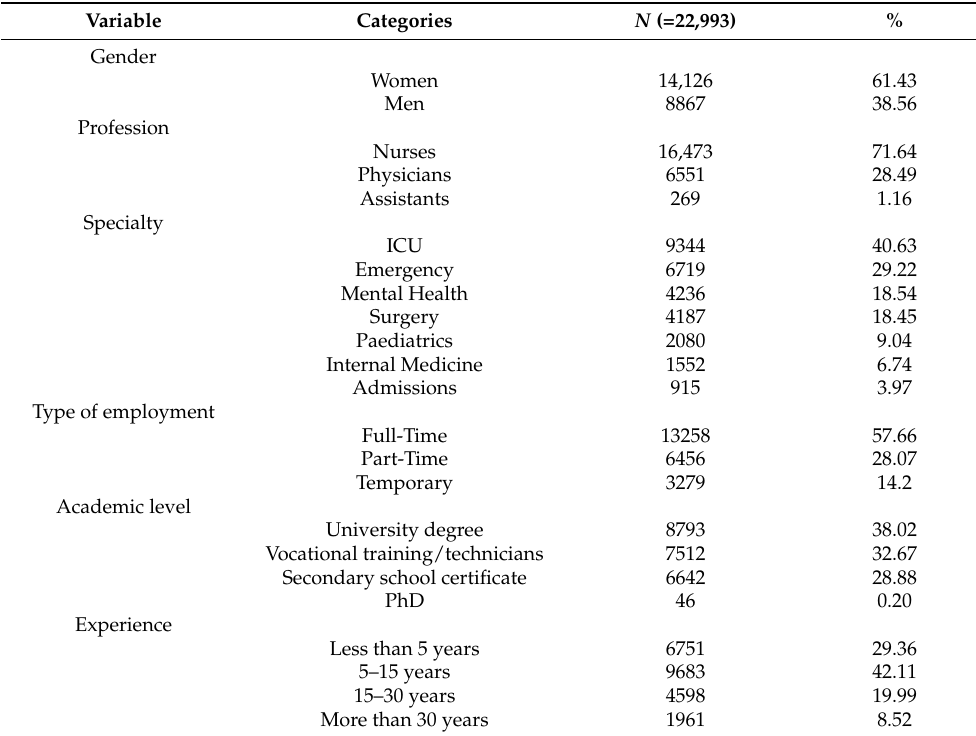
Table 2. Descriptive results.